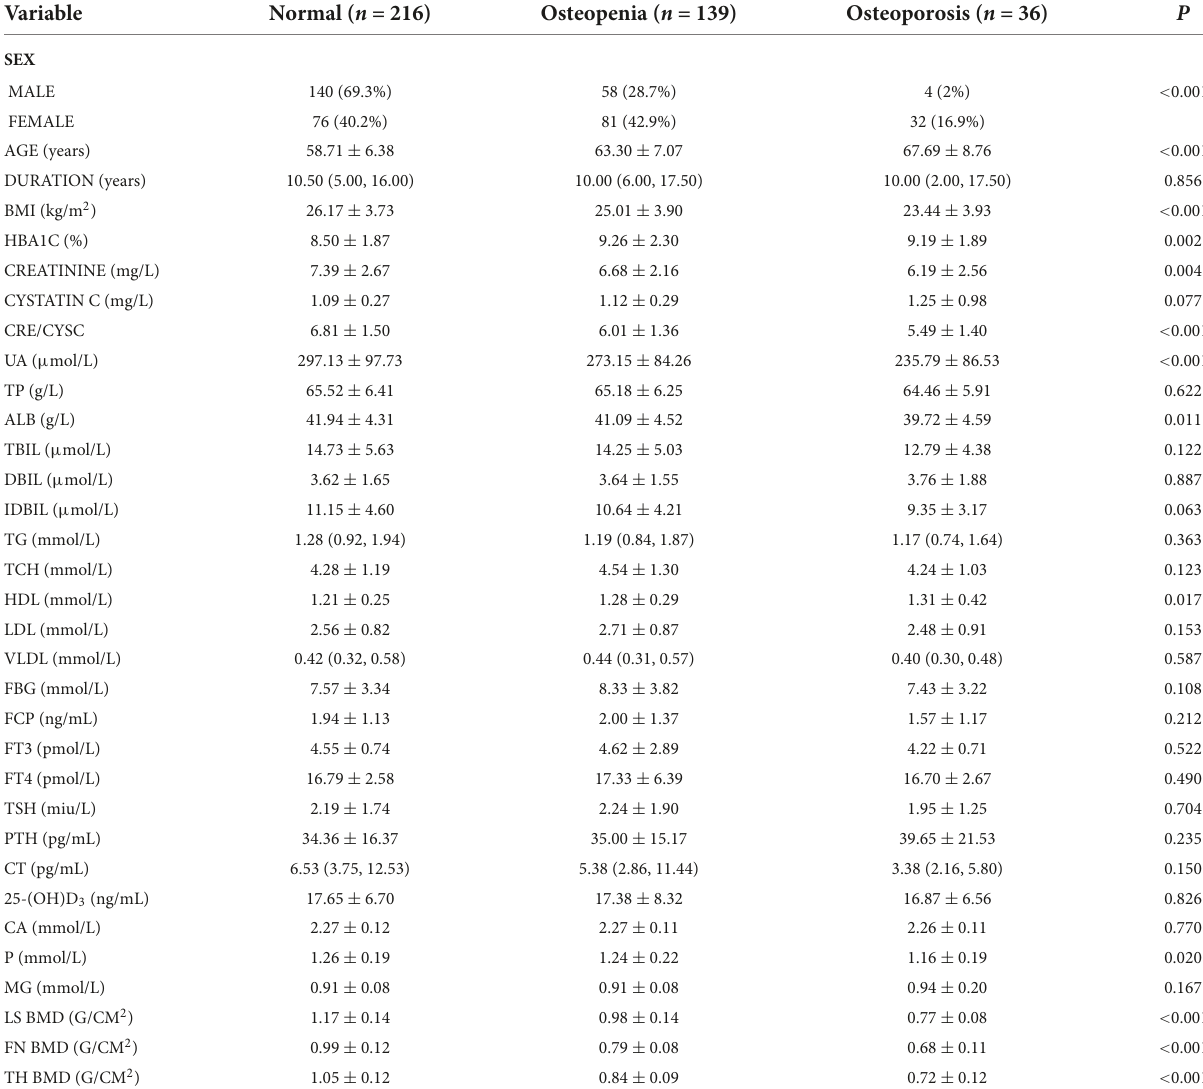
TABLE 4 Characteristics of patients in the normal, osteopenia, and osteoporosis group. Variable Normal ( n = 216) Osteopenia ( n = 139) Osteoporosis ( n =